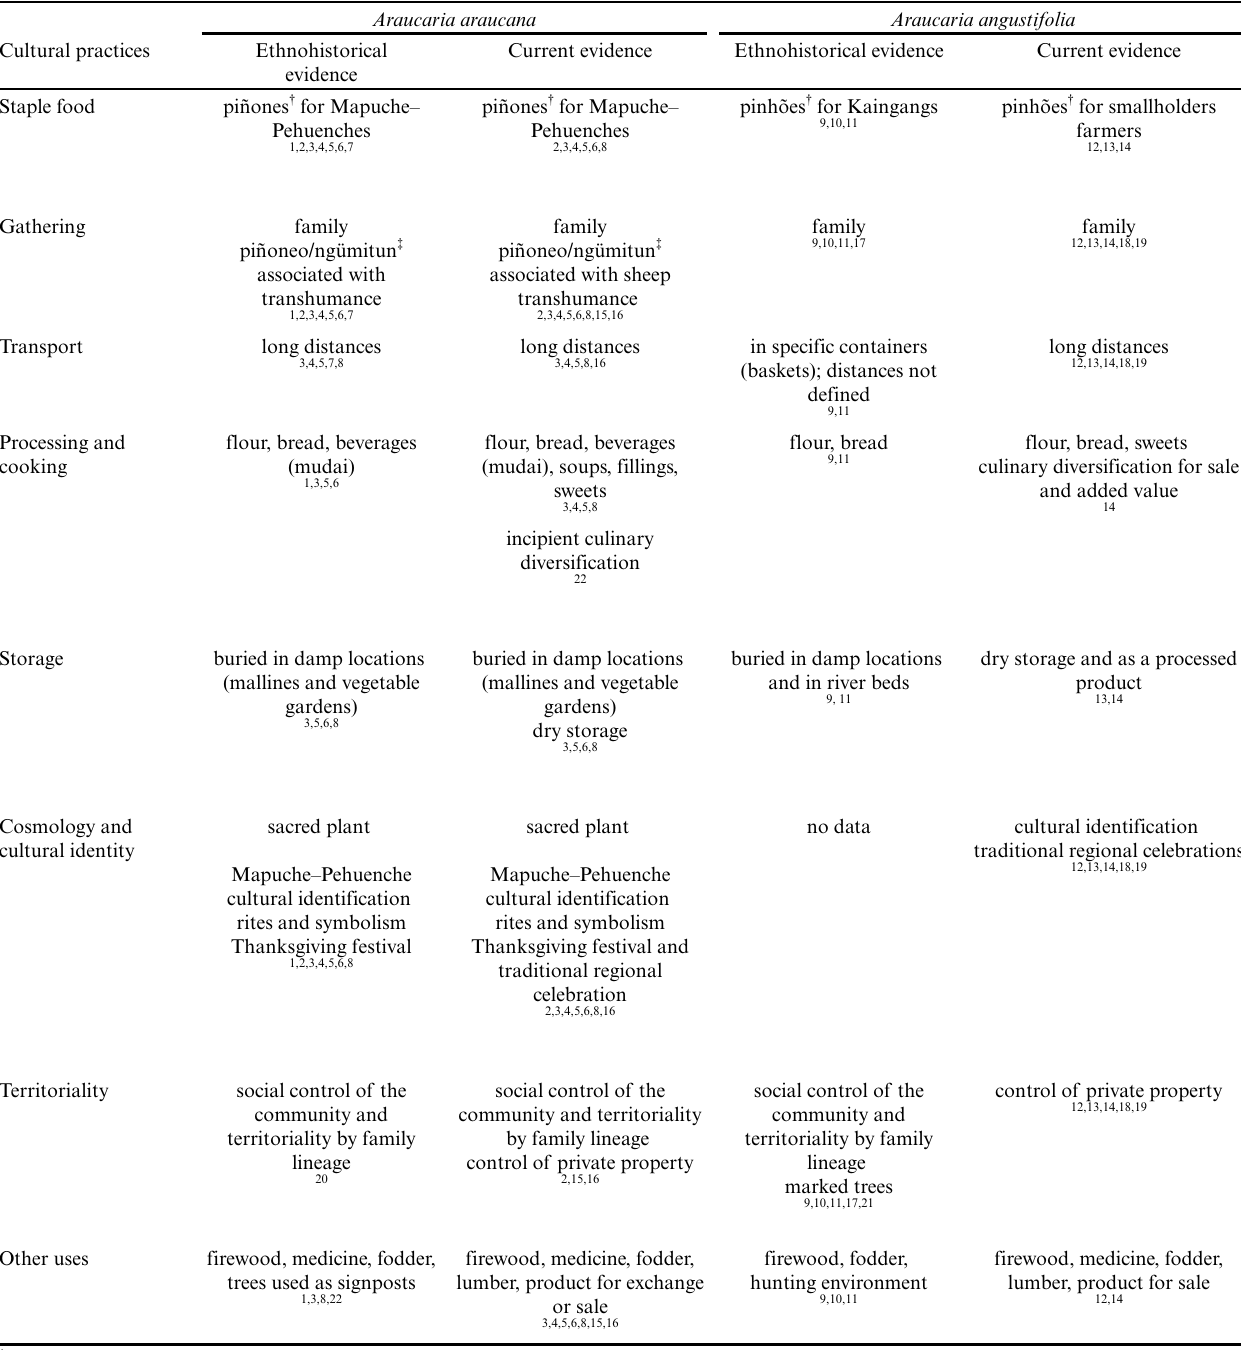
Table 2. Ethnohistorical evidence and current cultural practices and uses associated with the South American Araucaria